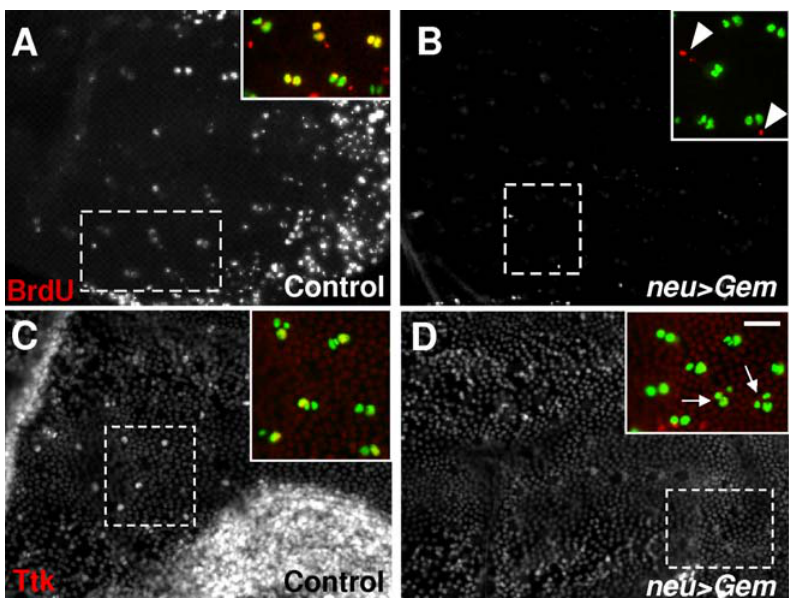
Figure 6. S-phase suppression decreased ttk gene expression. Low magnification views of nota in neu . H2B::YFP pupae in A and C and neu . H2B::YFP,Gem pupae in B and D. The incorporation of BrdU is shown in frames A and B while the expression of ttk is shown in C and D. The dotted squares denote the region that is detailed in the respective inset in which sensory cells are shown in green and BrdU or Ttk in red. BrdU incorporation was completely abolished in secondary precursor cells after specific ectopic expression of Gem (compare A and B) but not in epidermal cells (arrowheads in the inset of B). Note that Ttk expression was considerably reduced after specific ectopic expression of Gem (compare C and D). Arrows in D indicate three-cell sensory organs. Pupae at 19 h APF. Conditional expression of Gem was performed using the Gal4/ Gal80 ts system. Scale bar: 20 m m.